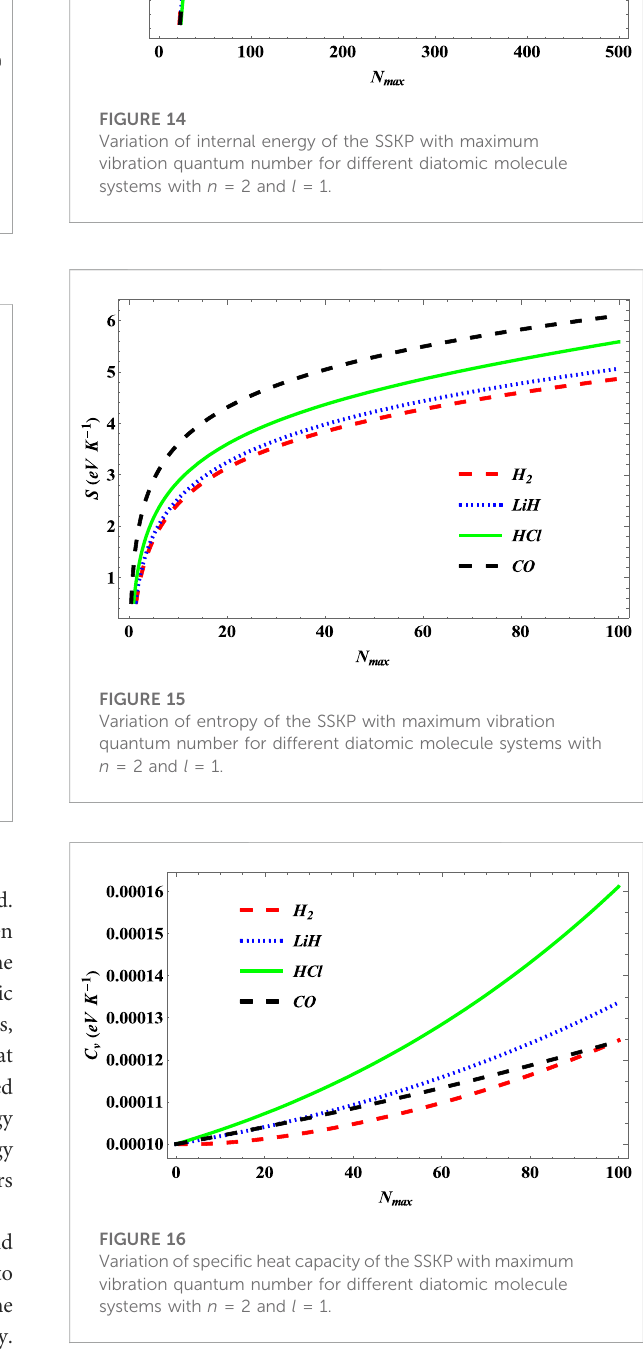
FIGURE 16 Variation of speci fi c heat capacity of the SSKP with maximum vibration quantum number for different diatomic molecule systems with n = 2 and l =